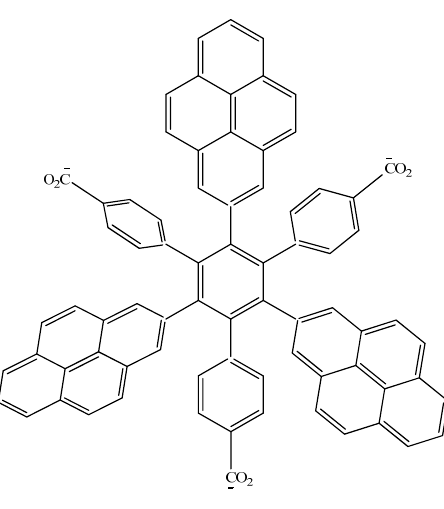
Figure 18. Structure of HAB9 .